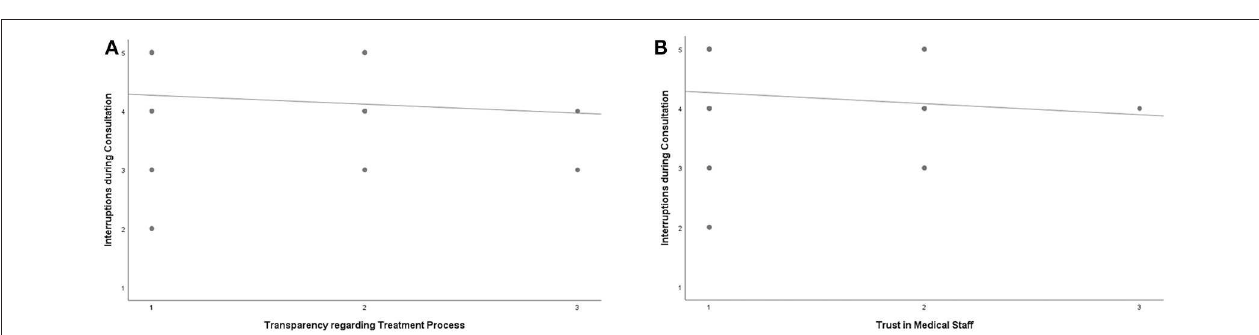
FIGURE 1 | (A–D) *Length of consultation was positively correlated to (A) Transfer of Medical Knowledge r = 0.458, p = 0.000, (B) Transparency regarding treatment process r = 0.636, p = 0.000, (C) Perceived Situational Control r = 0.341, p = 0.012, (D) Trust in Medical Staff r = 0.501, p = 0.000 x-axis: 1 = successful to 3 = minor success y-axis: 1 = appropriate to 5 = too